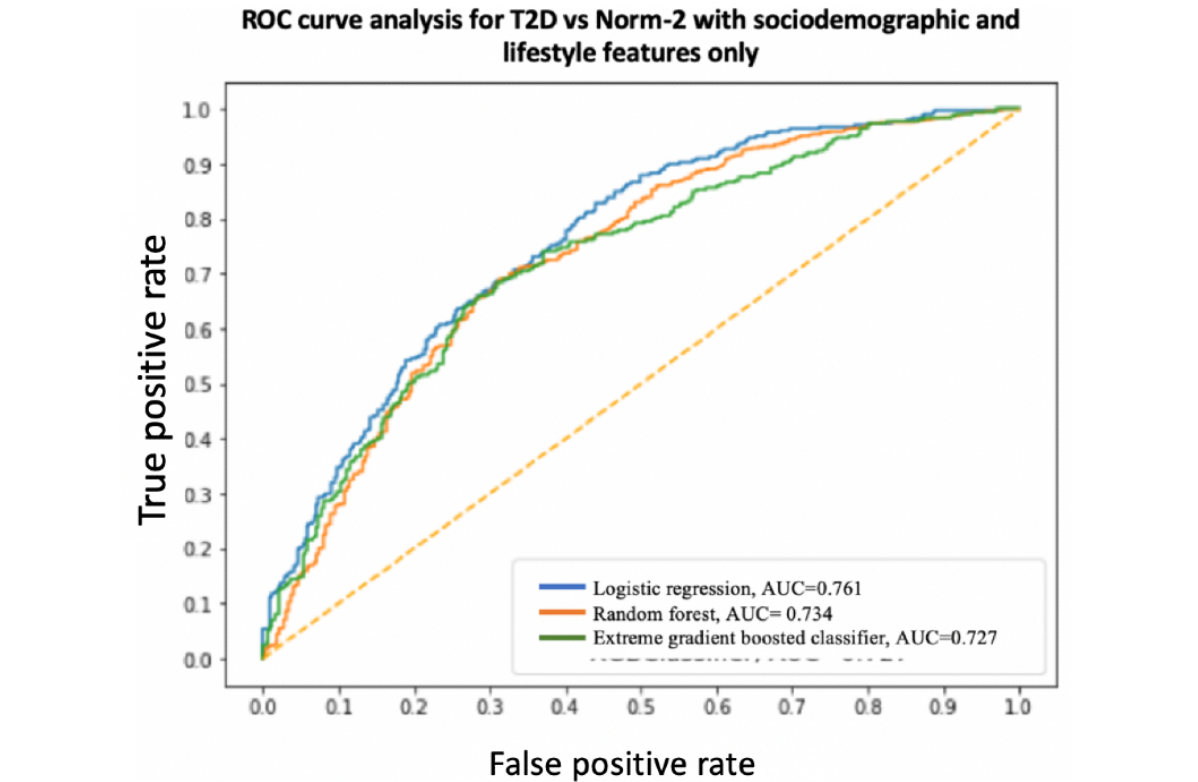
Figure 12. Receiver operating characteristic curve and area under the receiver operating characteristic curve for type 2 diabetes vs Norm-2: Sociodemographic and lifestyle features only. AUC: area under the receiver operating characteristic curve; ROC: receiver operating characteristic curve; T2D: type 2